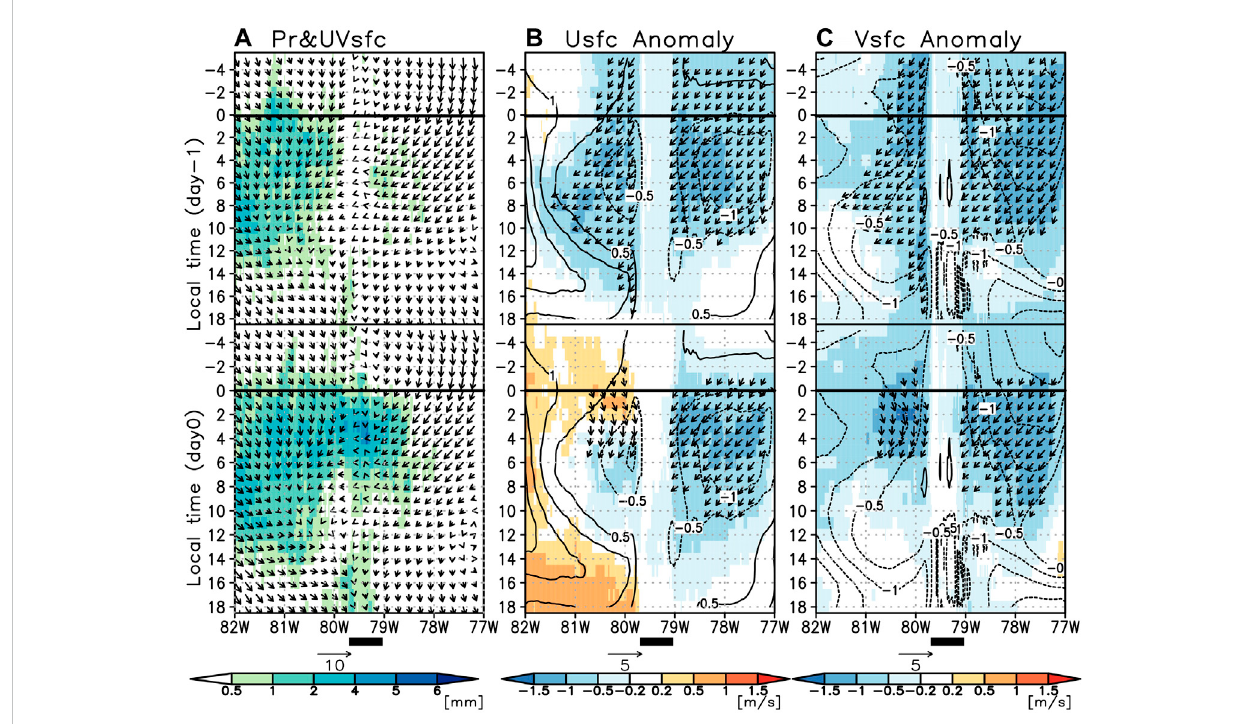
FIGURE 5 Two-day composited precipitation and winds of the longitude – time section at 9.5 ° N when the morning rain was > 1 mm on day0 and < 1 mm on day-1. Surface winds (arrows) and precipitation (shading) are shown in (A) . Anomalous easterly and northerly wind speeds are denoted by the shading in (B) and (C) ,whichisoverlaidontheclimatologicalwindspeedindicatedbythecontours.Arrowsin (B) and (C) indicatetheanomaloussurfacewindswhen the anomalous wind speeds exceed 1